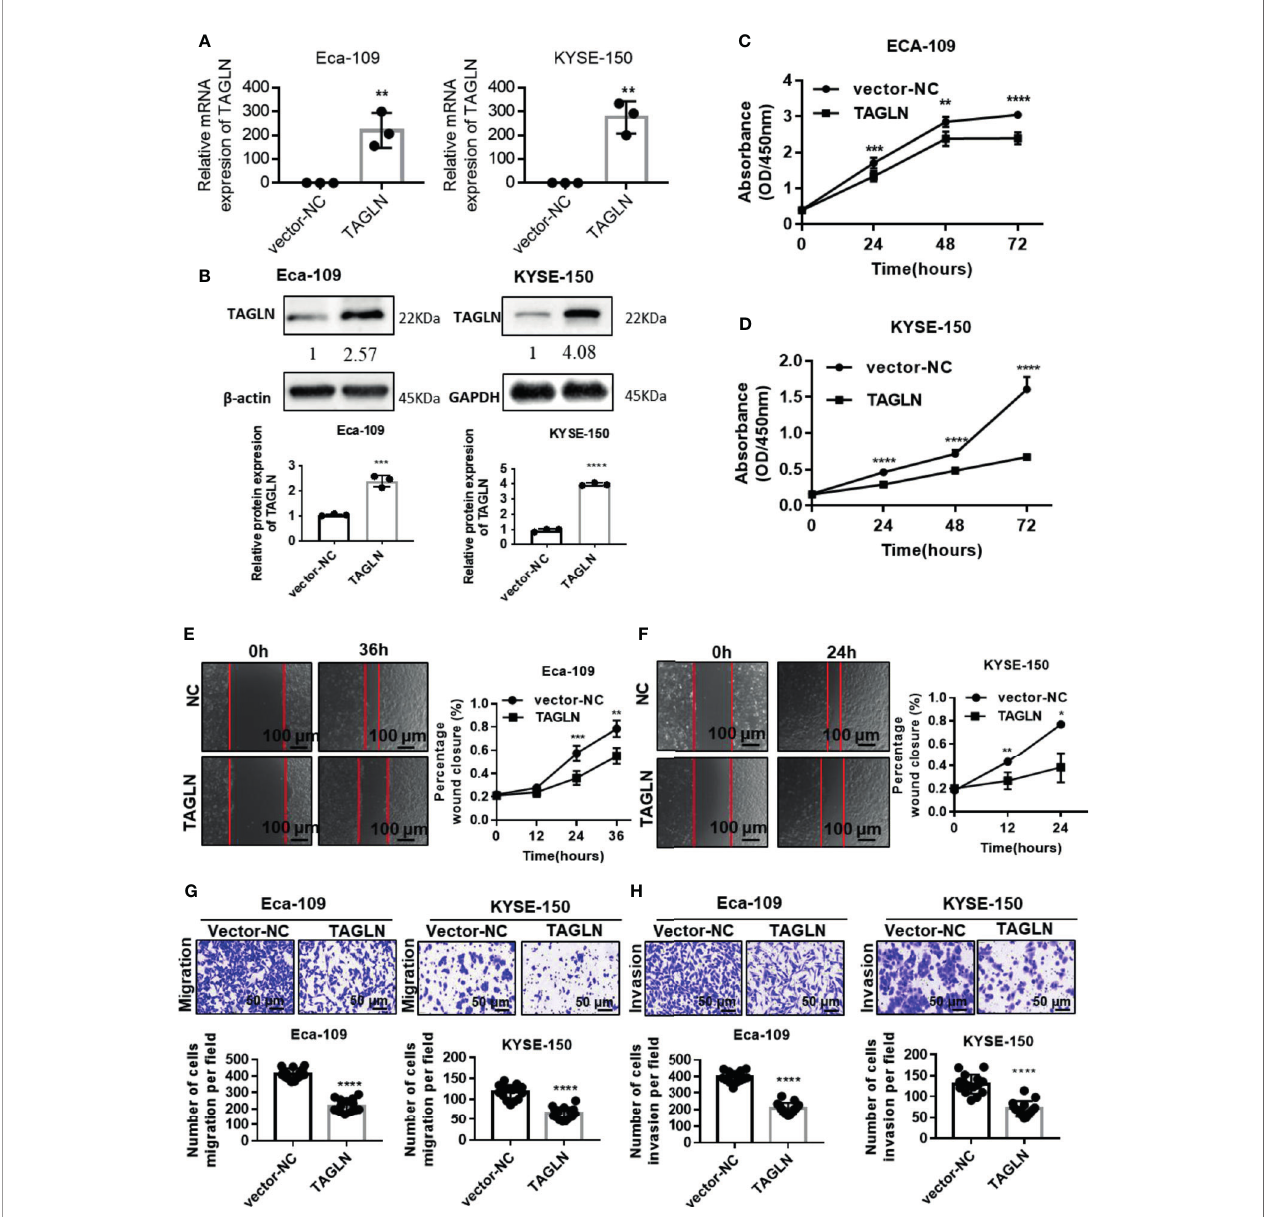
FIGURE 2 | Over-expression Transgelin suppresses the proliferation, migration and invasive abilities of esophageal squamous cell carcinomas cells in vitro . (A) Eca- 109 and KYSE-150 cells transfected with Transgelin overexpression vector, respectively. The expression of Transgelin was veri fi ed by qRT-PCR. (B) Eca-109 and KYSE-150 cells transfected with Transgelin overexpression vector, respectively. The expression of Transgelin was veri fi ed by western blotting. GAPDH and b -Actin were used as internal controls. (C) The effects of Transgelin overexpression on the proliferation ability was analyzed by CCK-8 kit in Eca-109 cells. (D) The effects of Transgelin overexpression on the proliferation ability was analyzed by CCK-8 kit in KYSE-150 cells. (E) The effects of Transgelin overexpression on the migration ability was analyzed by Scratch test in Eca-109 cells. (F) The effects of Transgelin overexpression on the migration ability was analyzed by Scratch test in KYSE-150 cells. (G) The effects of Transgelin overexpression on the migration ability was analyzed by transwell assay in Eca-109 and KYSE-150 cells. (H) The effects of Transgelin overexpression on the invasion ability was analyzed by transwell assay in Eca-109 and KYSE-150 cells The data are presented as the mean ± SEM of three independent experiments. * P < 0.05, ** P < 0.01, *** P < 0.001, and ****P < 0.0001 by two-tailed Student ’ s